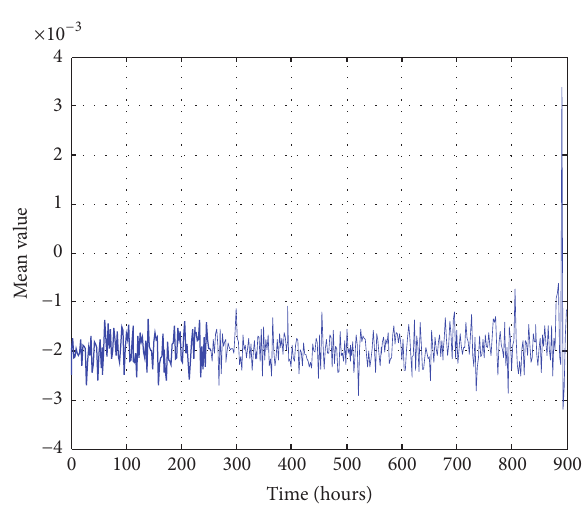
Figure 9: Mean value.